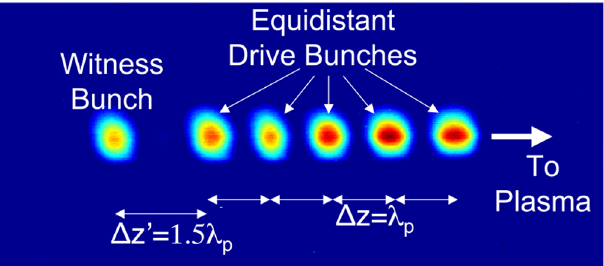
FIG. 12. (Color) Train of bunches for PWFA applications mea- sured in the energy plane: five equidistant drive bunches fol- lowed by a witness bunch, with a separation one and a half times that of the drive bunches. CTR measurements show that the same pattern is obtained in time (see Fig. 13).